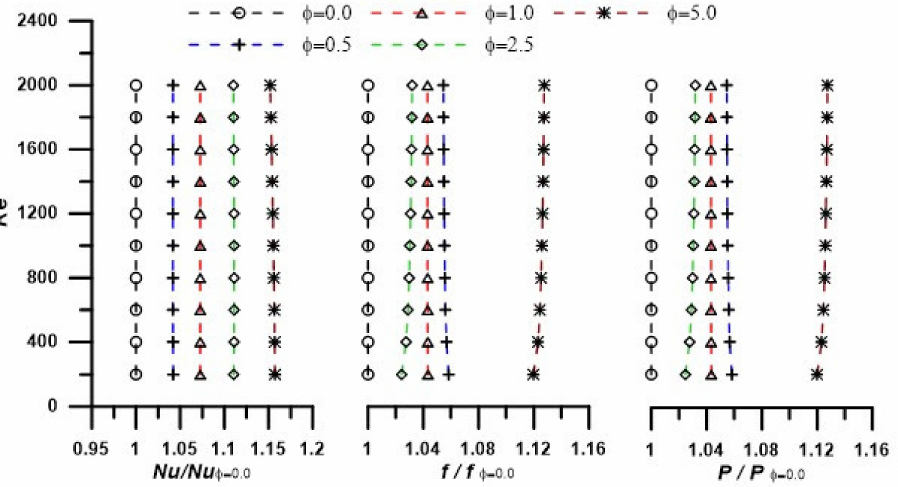
Figure 4. Nusselt number ratio, friction factor ratio, and dimensionless pressure drop ratio at T = 303.15 K for investigated